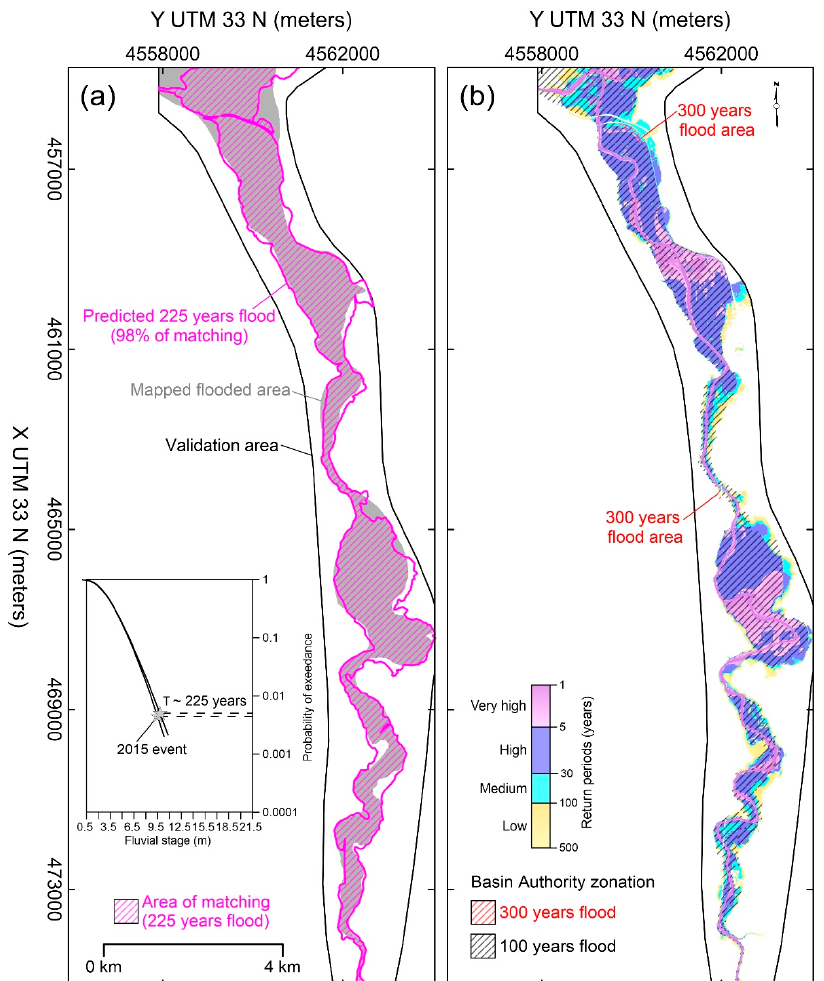
Figure 6. ( a ) Results of validation by means of comparison with a known 225-years flood event mapped in the lower reach of the Calore river on October 2015 (data from [22]). Inset graph